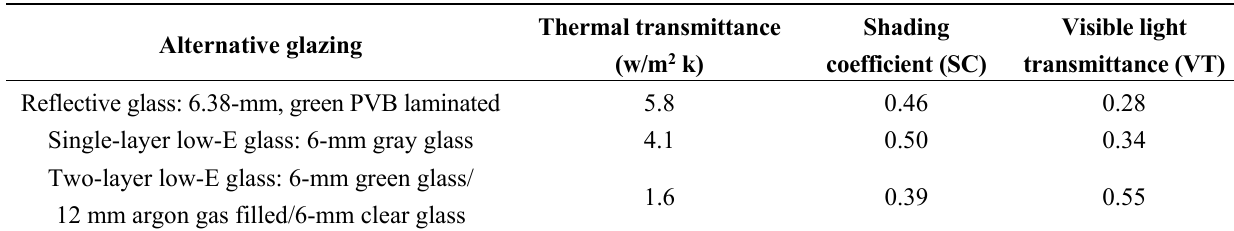
Table 5. Thermal properties of the glazing alternatives.